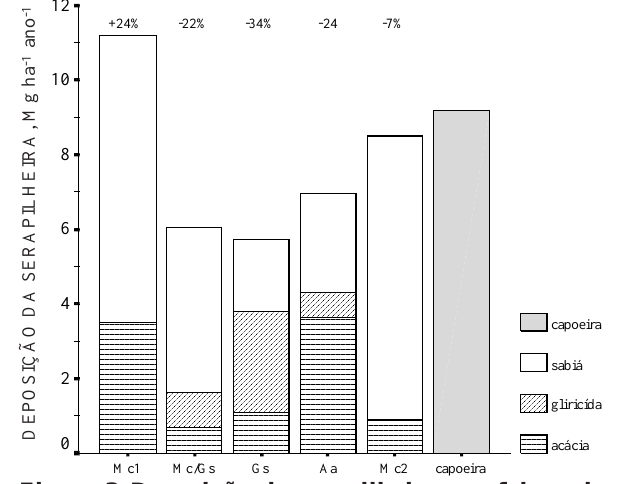
Figura 3. Deposição de serapilheira nas faixas de coberturas da revegetação, diferenciando a contribuição de cada espécie de leguminosa. Os valores dos rótulos sobre as barras indicam a diferença percentual em relação à capoeira, em que Mc1 = faixa com predomínio de sabiá; Mc/Gs = faixa com sabiá e gliricídia; Gs = faixa com predomínio de gliricídia; Aa = faixa com predomínio de acácia; Mc2 = faixa com predomínio de